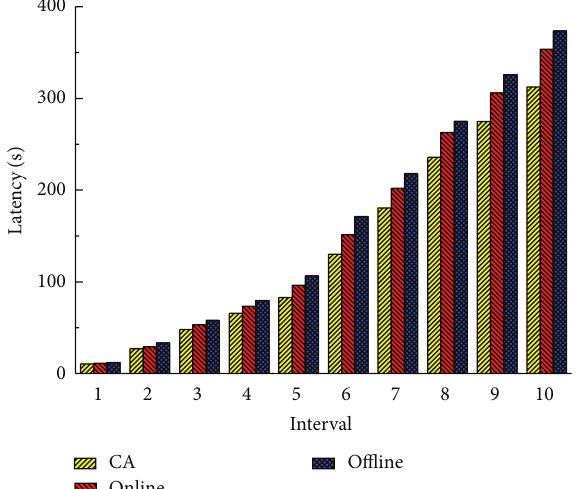
Figure 6: Total latency of all services (20 nodes).